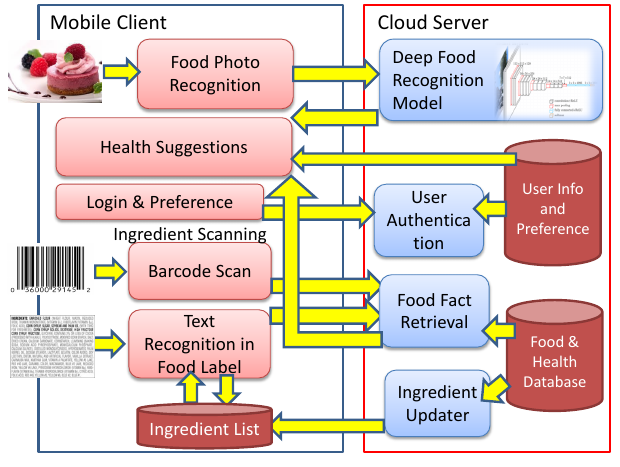
Figure 2. System